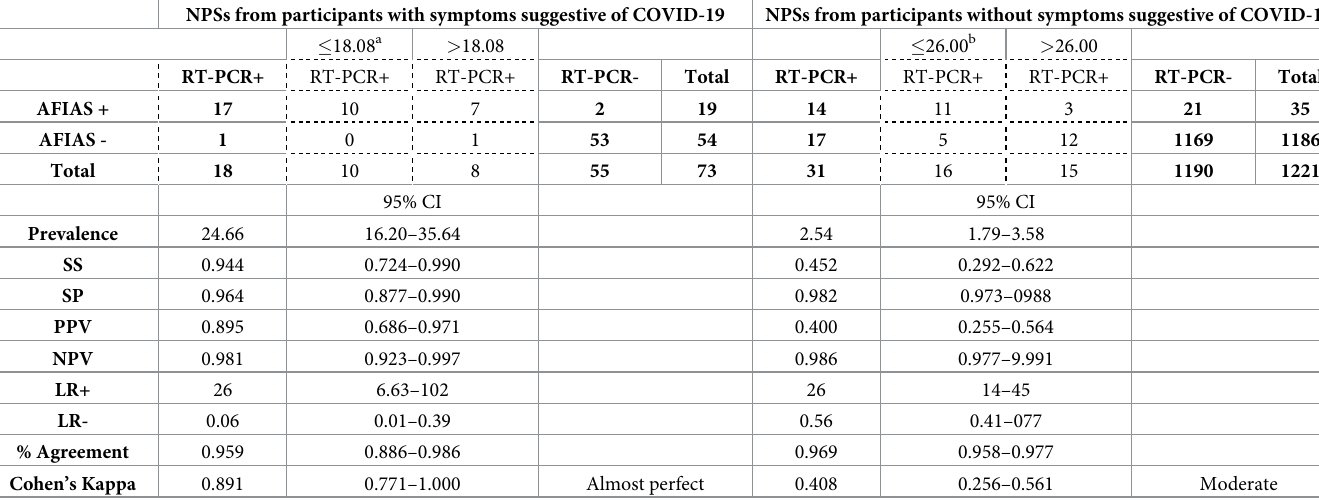
Table 4. Diagnostic accuracy of AFIAS COVID-19 Ag test according to presence or absence of COVID-19 symptoms. NPSs from participants with symptoms suggestive of COVID-19 NPSs from participants without symptoms suggestive of